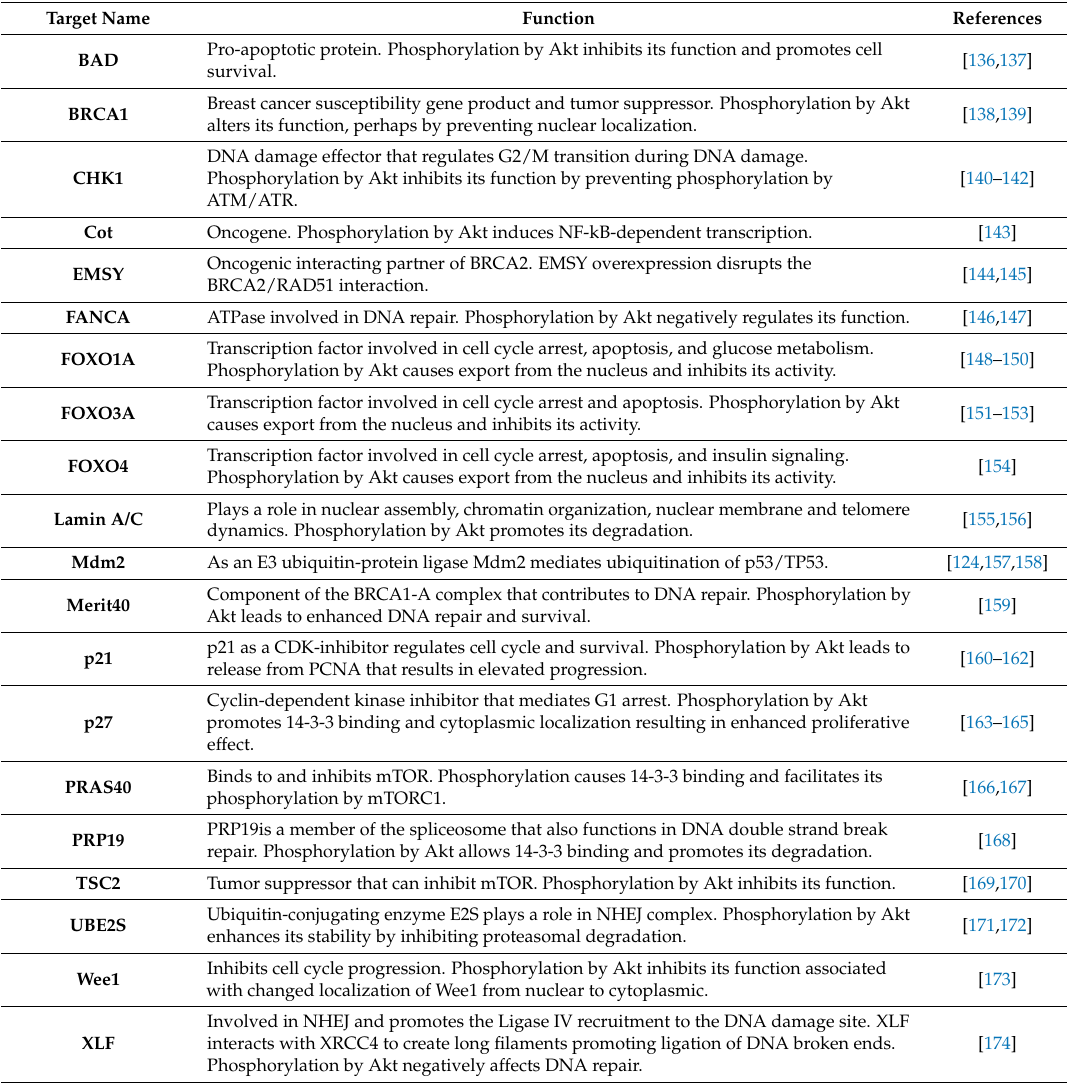
Table 2. Documented Akt target